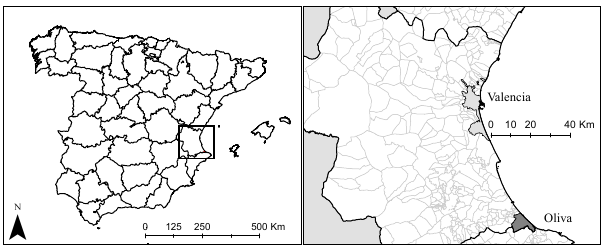
Figure 4. Location of the case study area at national (left) and re- gional (right)